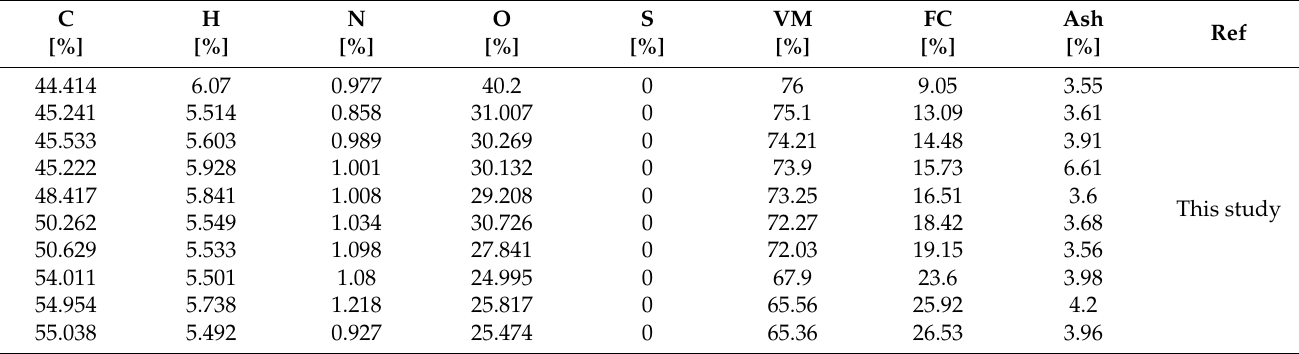
Table 1. Data set for correlation validation (n =